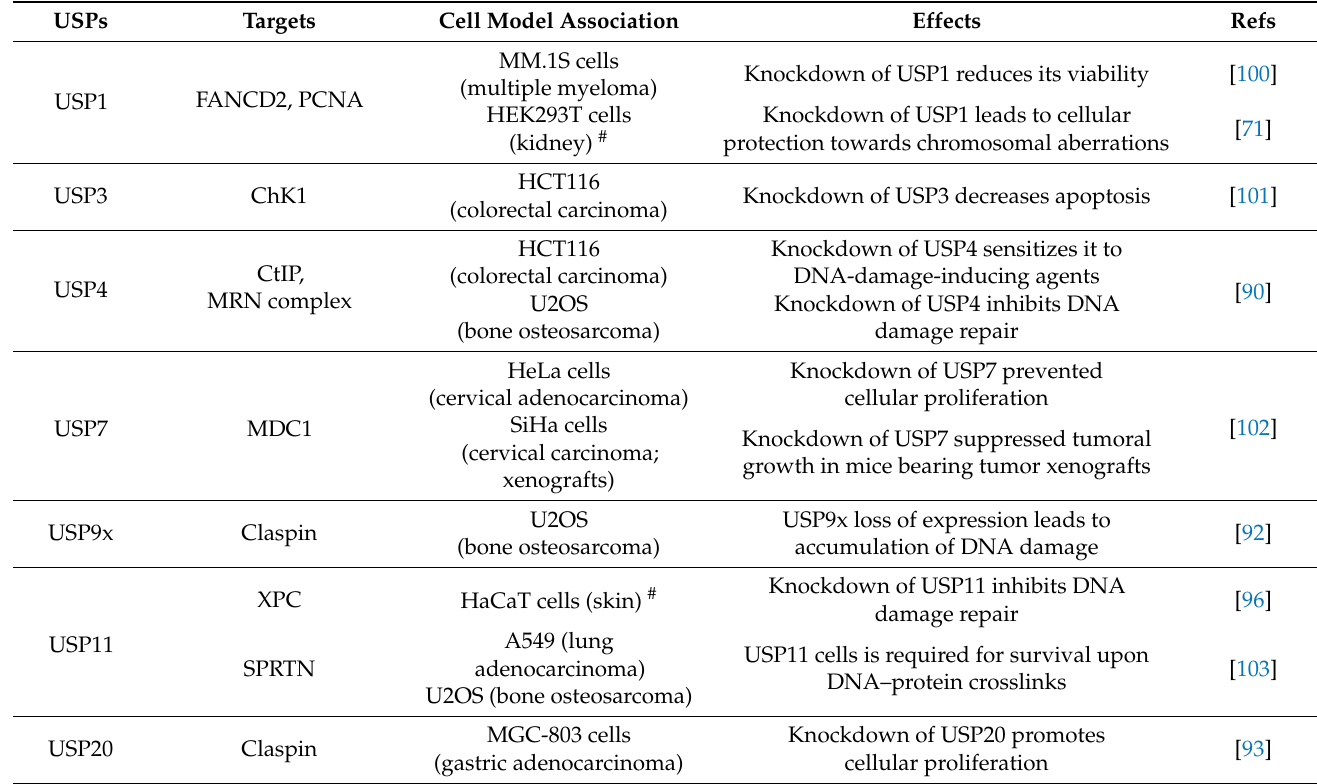
Table 2. Summary of cellular consequences resulting from interactions between different USPs and target proteins associated with DNA damage